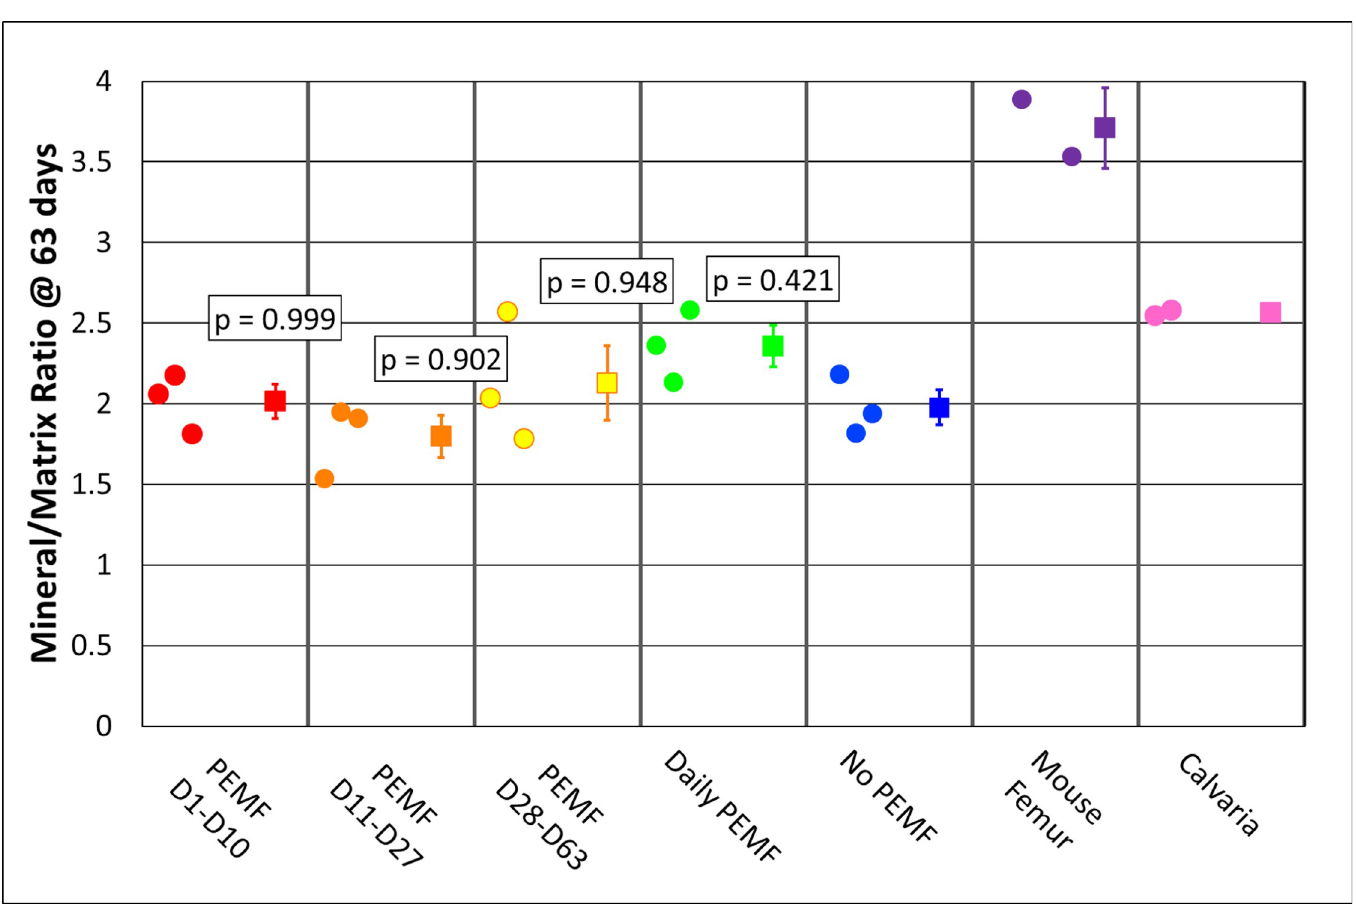
Fig 9. TGA analysis for mineral/matrix ratio of ring constructs on Day 63, comparison with calvaria and femur. Each group column presents individual values on the left and the mean and standard error on the right if n is 3 or greater. p-value = Tukey HSD, alpha = 0.05.